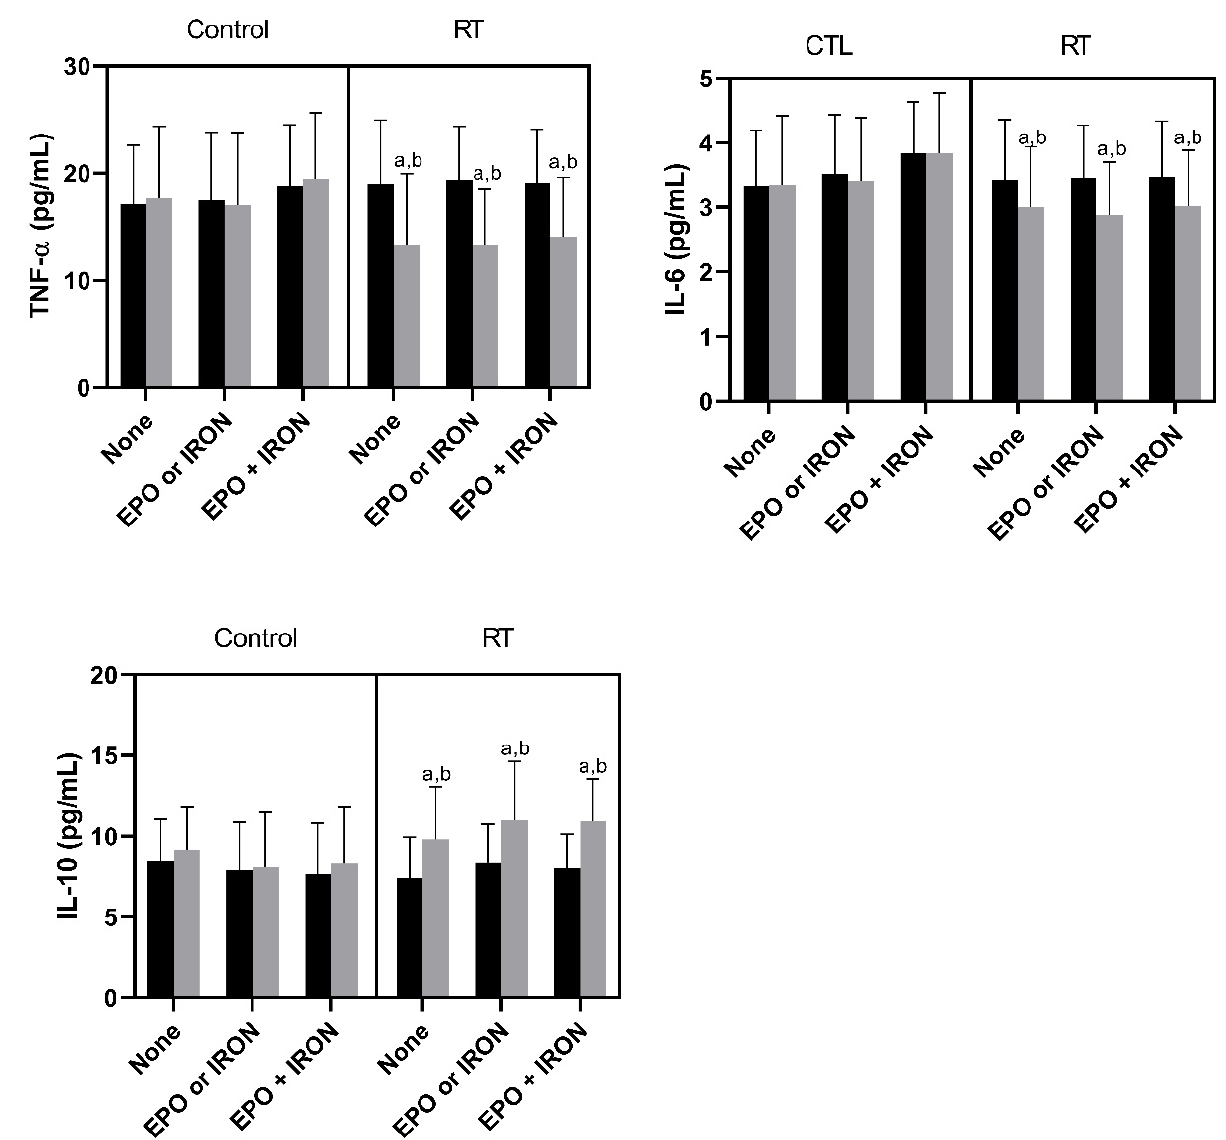
Figure 3. Cytokine modulation following RT in hemodialysis patients. RT: resistance training; EPO: erythropoietin; TNF: tumor necrosis factor; IL: interleukin. Data expressed by mean ± SD. a p < 0.05 in relation to pre (within group and treat- ment). b p < 0.05 in relation to CTL post (between group and within treatment).